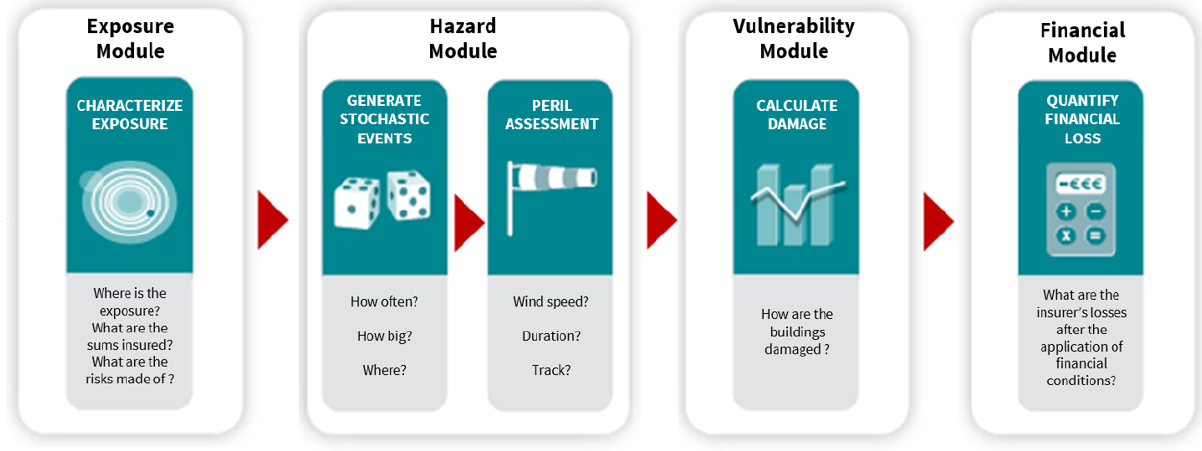
Figure 1. Loss modelling framework composed of four components. A simulation engine is used to intersect the exposure information with the catalogue of hazard events and apply the damage ratio characterized with the vulnerability curve, function of hazard, and building characteristics. This operation leads to a loss, gross of any financial insurance conditions. The application of the financial conditions is performed in the financial